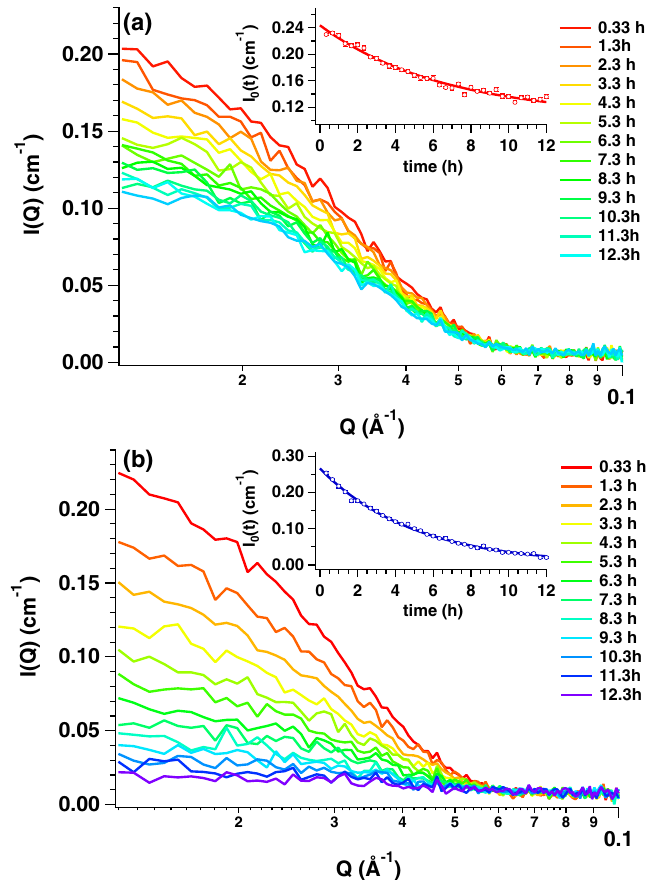
Figure 2. Time evolutions of the SANS profile after being mixed with OLG(0) and OLG(26) for the dilute and dense samples. ( a ) Time evolution of the SANS profile after being mixed with OLG(0) at 0.45 mg/mL and OLG(26) at 0.45 mg/mL (dilute sample) at 37 °C (red to light blue lines correspond to the SANS profile at 0.33 h and to that at 12.3 h). The inset indicates I 0 ( t ), and the red solid line corresponds to the fit with Eq. (2). ( b ) Time evolution of the SANS profile after being mixed with OLG(0) at 0.45 mg/mL and OLG(26) at 28.5 mg/ mL (dense sample) at 37 °C (red to purple lines correspond to the SANS profile at 0.33 h and to that at 13.3 h). Insets indicate I 0 ( t ), and the blue solid line corresponds to the fit with Eq. (2). This figure is prepared by the usage of IGOR Pro 6.34A (https ://www.wavem etric s.com/forum /news-and-annou nceme nts/igor-634a-now- shipp